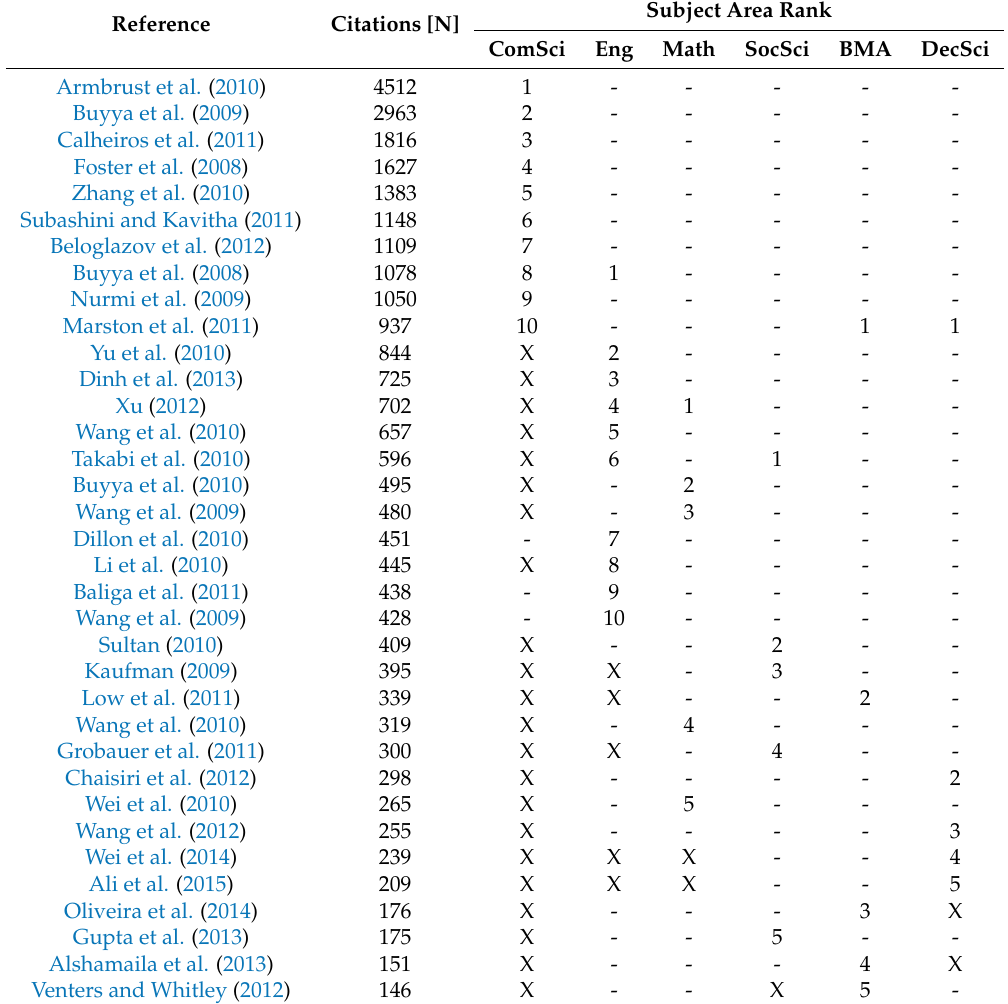
Table 7. Core references in research on cloud computing by a subject